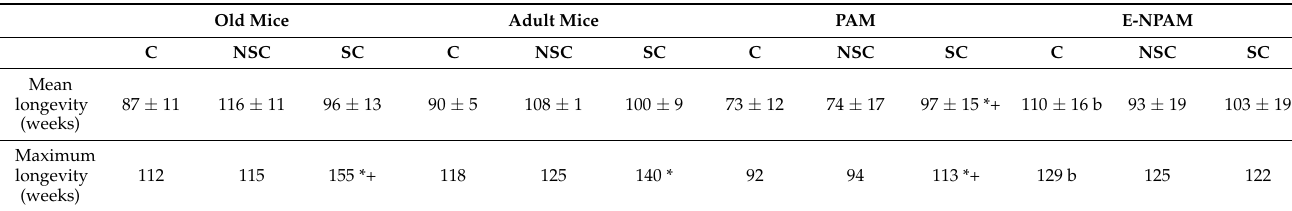
Table 4. Longevity